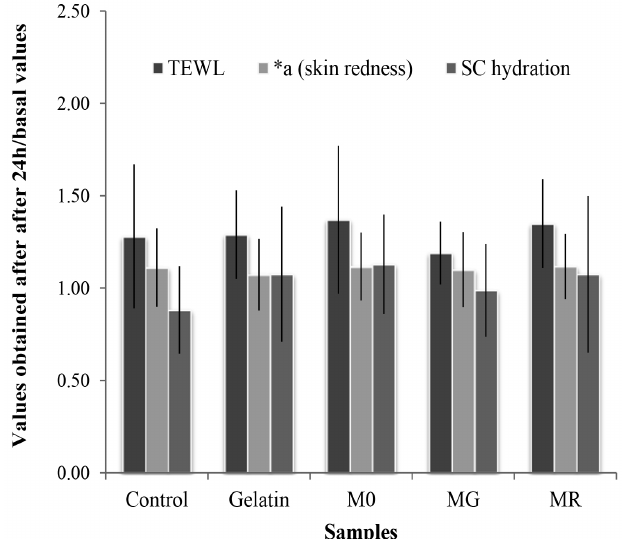
FIGURE 4 - In vivo cutaneous compatibility assays established by non-invasive methods (TEWL: transepidermal water loss; skin redness; and SC hydration: stratum corneum . M0: uncrosslinked gelatin microspheres; MG: gelatin microspheres crosslinked with GTA; MR: gelatin microspheres crosslinked with